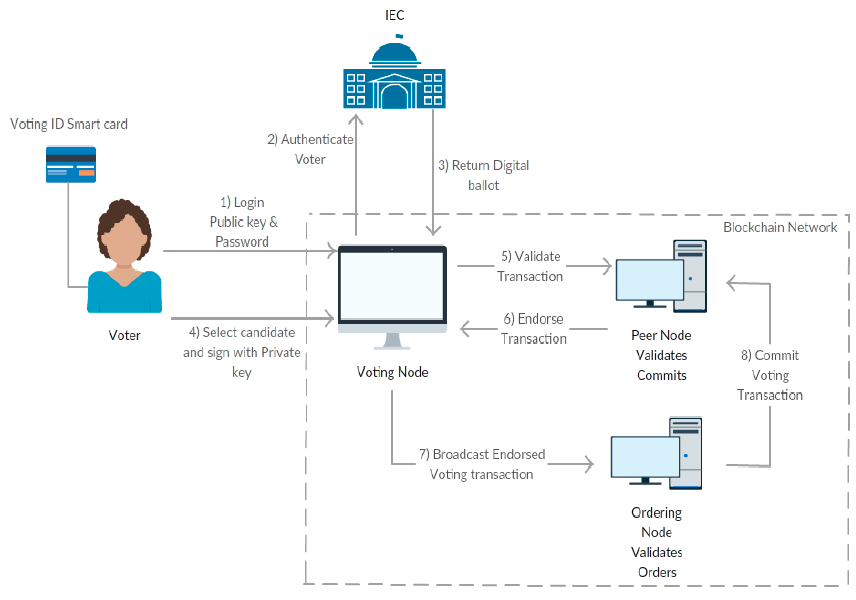
Figure 2. A high-level view of the e-voting process using the BANES.